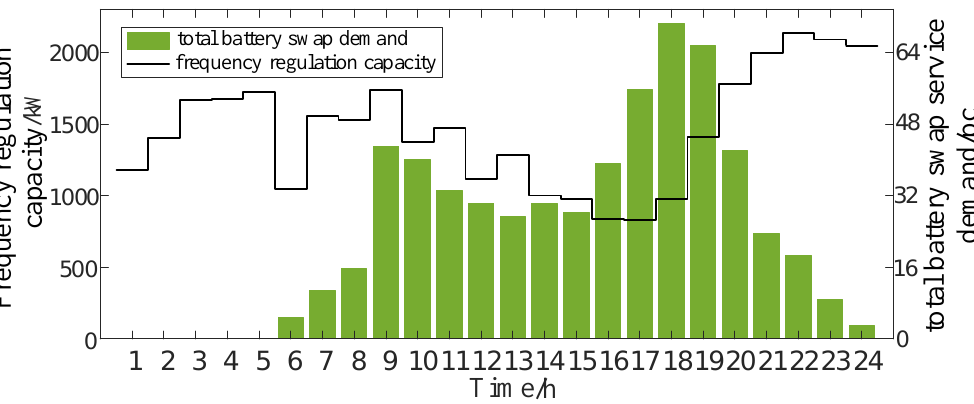
Figure 4. Comparison between the FR capacity and the total battery swap demand.